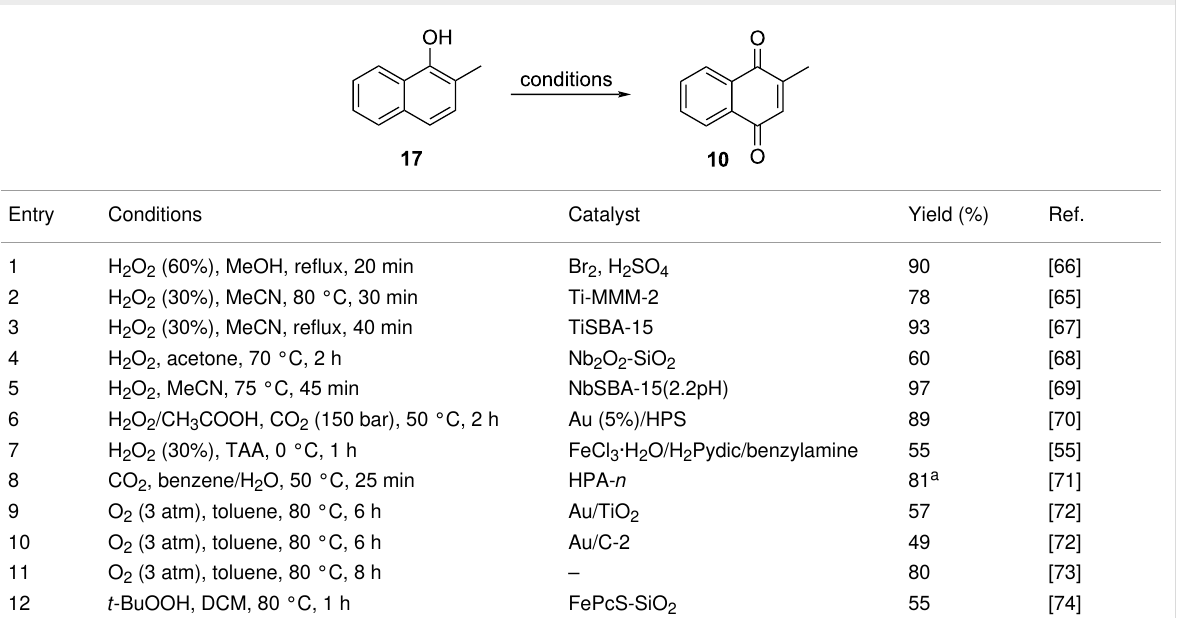
Table 2: Approaches for the oxidation of 2-methylnaphthol to menadione ( 10